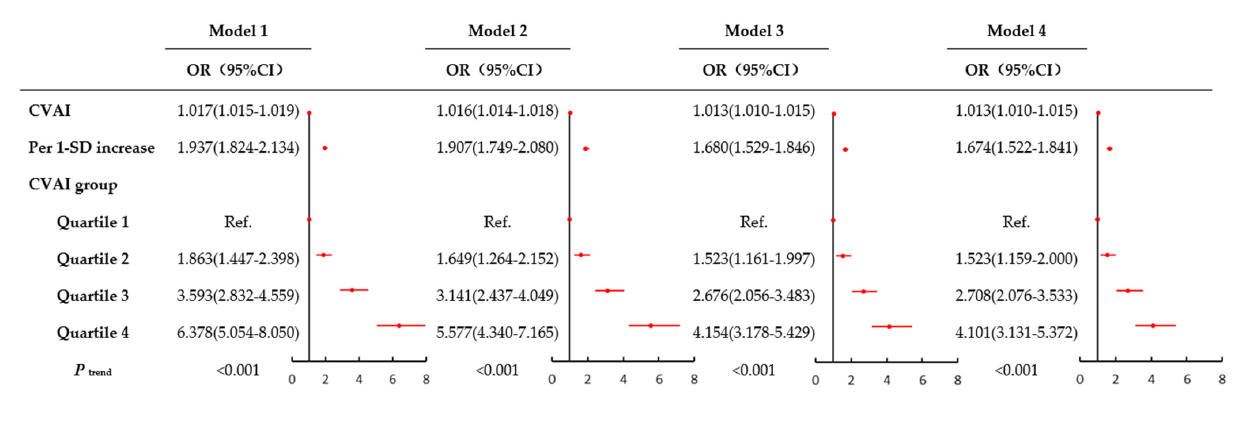
Figure 2. Association between CVAI and the risk of CAS prevalence. CVAI: Chinese Visceral Adiposity Index, CAS: carotid atherosclerosis, OR: odds ratio, CI: confidence interval. Model 1: crude model; Model 2: adjusted for age, sex, family history of CAS, education, marital status, income status, smoking, drinking, physical exercise, and diet; Model 3: further adjusted for hypertension, diabetes, dyslipidemia, uric acid, homocysteine, WBC, and hs-CRP; Model 4: further adjusted for exposure to high temperature, noise, and shifts. The linear trends between CVAI quartiles were assessed by entering the median of each quartile.